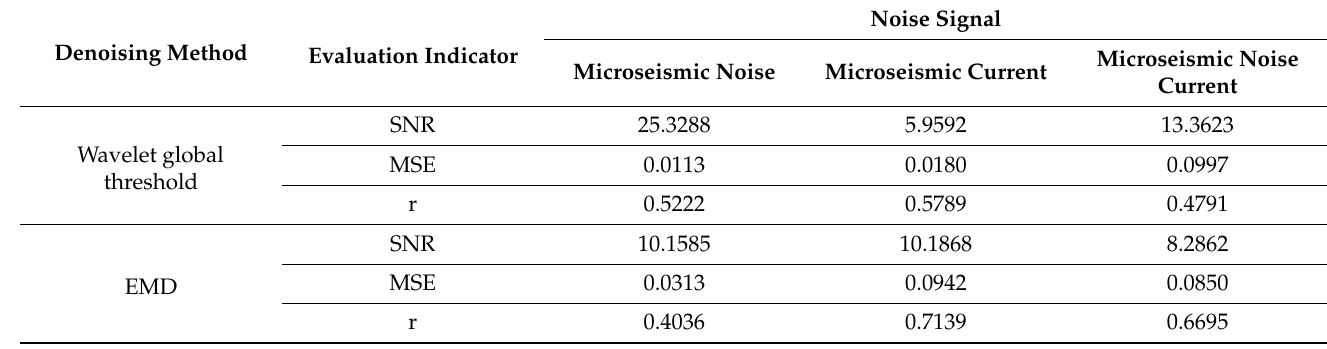
Denoising Method